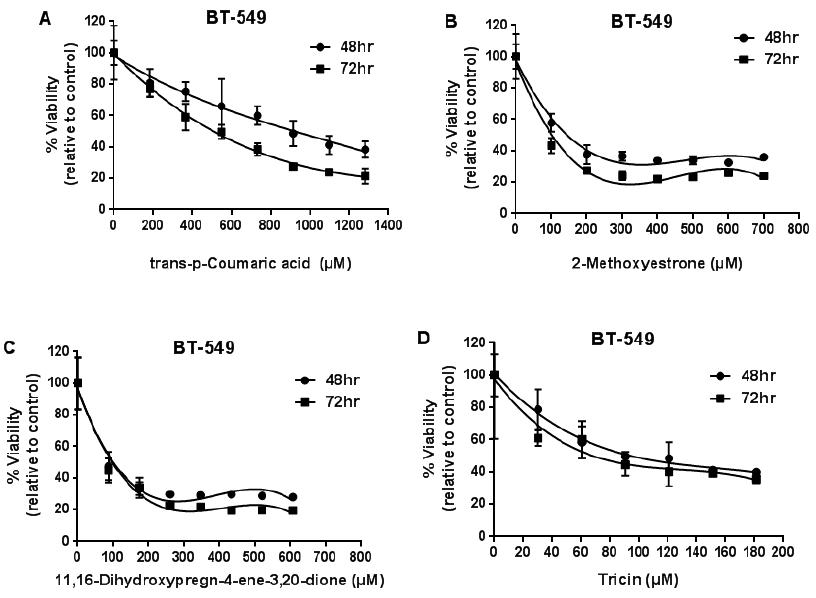
Figure 8. The growth inhibitory effects of compound ( 1 )–( 4 ) on BT-549 (breast cancer cell line) were evaluated after 48/72 h treatment by MTT assay.